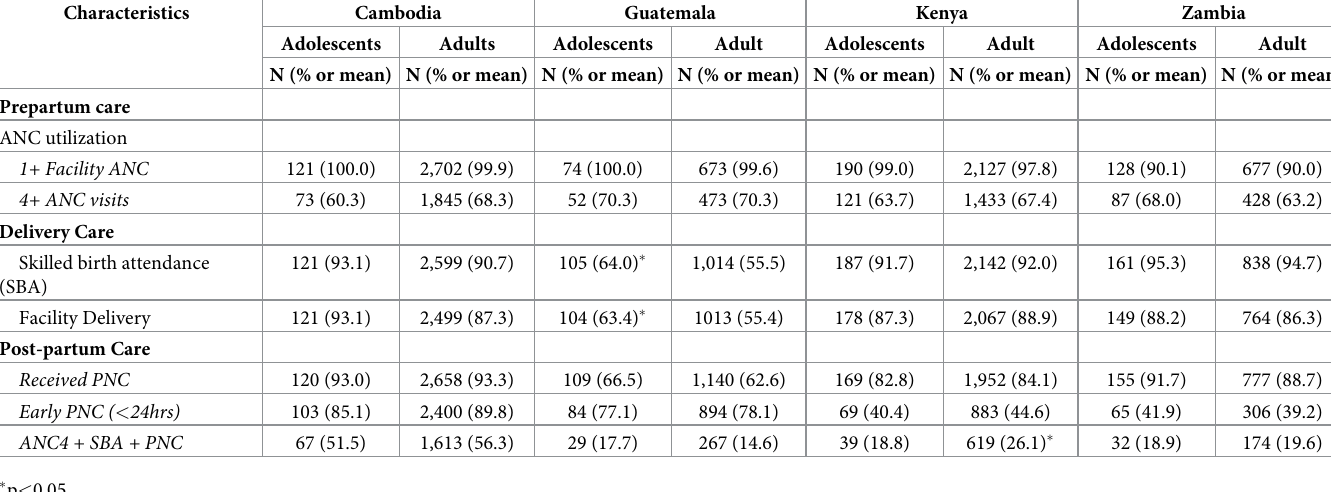
Table 3. Care-seeking characteristics for ANC, delivery care and PNC: Adolescent vs adults.